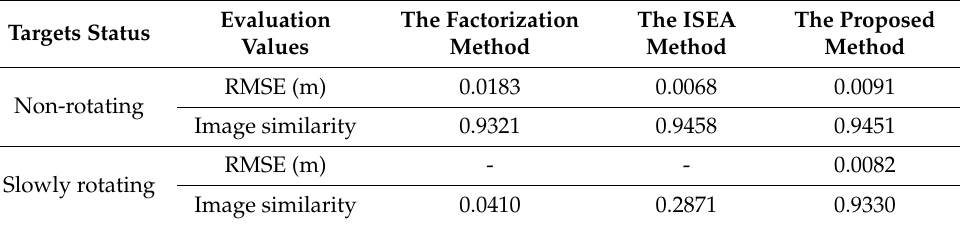
Table 3. Comparisons on the evaluation values of the reconstructed results.